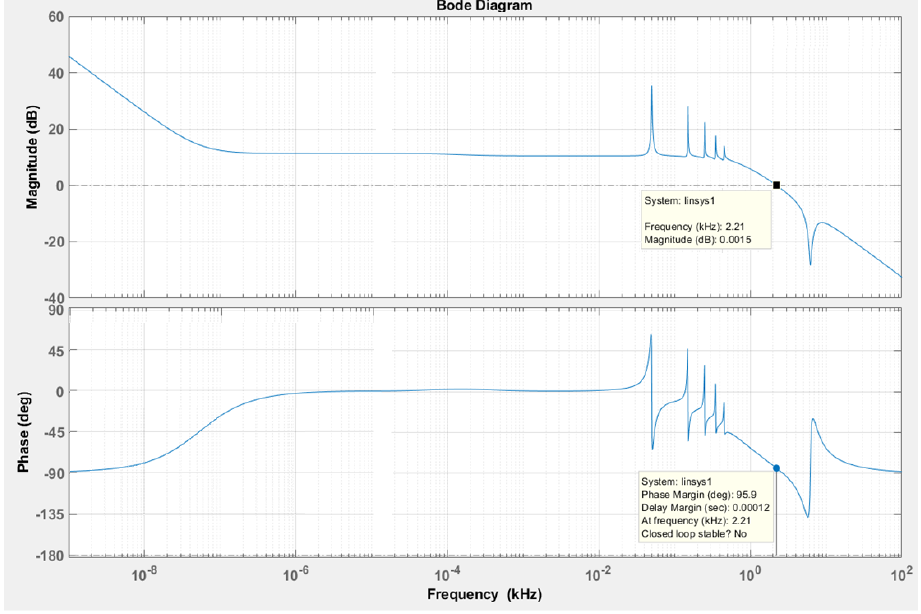
Figure 8. Bode plot of multi-resonant control